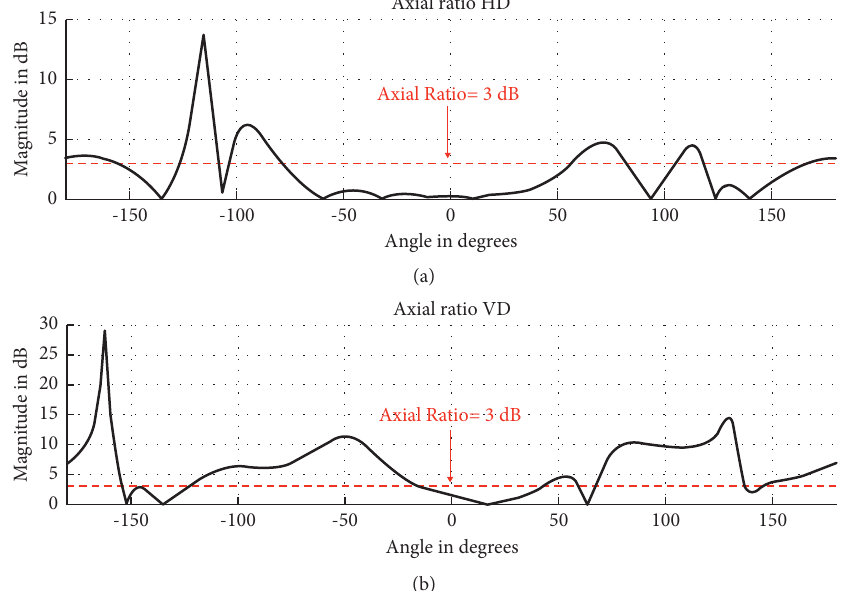
Figure 16: Measured axial ratio as function of angular coordinates for (a) horizontal diagram (HD) and (b) vertical diagram